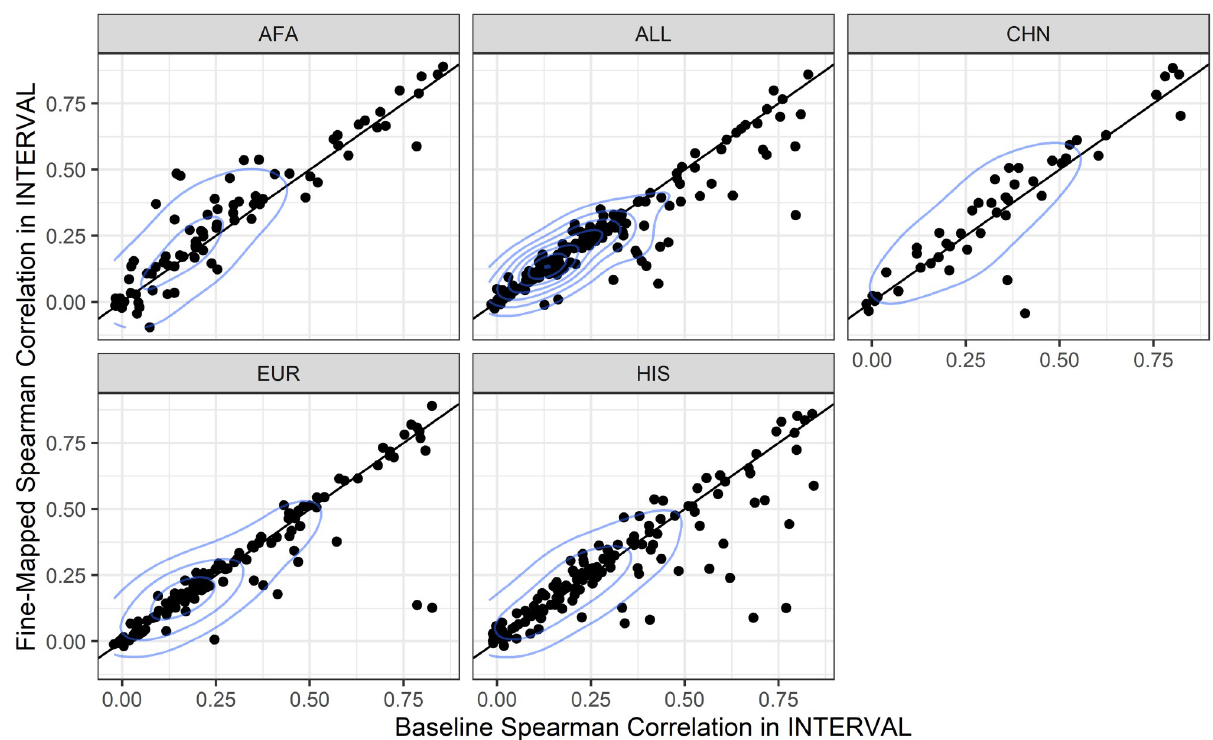
Fig 2. TOPMed MESA protein prediction model performance comparison in the independent INTERVAL population. Within each training population, the fine-mapped model performance in INTERVAL (y-axis) is compared to the baseline elastic net model performance in INTERVAL (x- axis). Each dot represents a protein that is predicted by both baseline models and fine-mapped models. Performance was measured as the Spearman ρ between the measured protein aptamer level and the predicted protein aptamer level. Fine-mapped models performed better than baseline models in AFA (Wilcoxon signed-rank test, p = 0.0016) and CHN ( p = 0.036), were not significantly different in EUR ( p = 0.74) and HIS ( p = 0.54), and significantly worse in ALL ( p = 0.0085). TOPMed MESA populations: AFA, African American; ALL, all populations combined; CHN, Chinese; EUR, European; HIS,